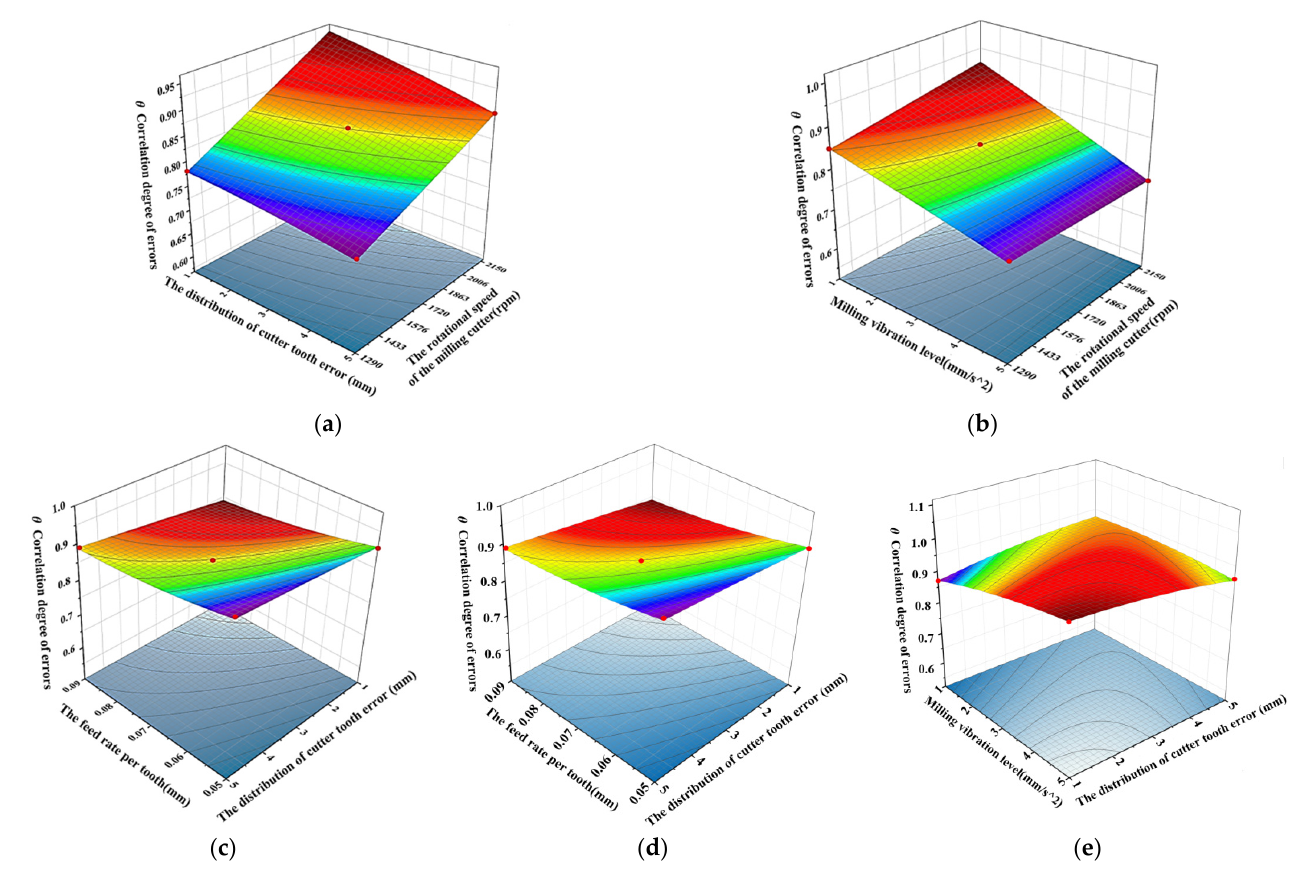
Figure 11. Response surface of design variable interactions with angular error: ( a ) The distribution of cutter tooth error and the rotational speed of the milling cutter. ( b ) The milling vibration level and the rotational speed of the milling cutter. ( c ) The speed rate per tooth and the distribution of cutter tooth error. ( d ) The feed rate per tooth and the milling vibration level. ( e ) The milling vibration level and the distribution of cutter tooth error.